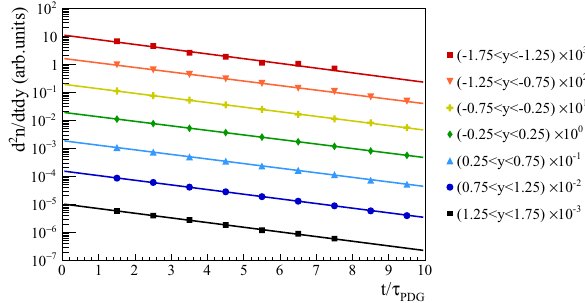
Fig. 7 Corrected lifetime distribution for K 0 inelastic p+p interaction at 158 GeV / c . The curves show the result of the exponential fit function used to obtain the mean lifetime. Statis- tical uncertainties are smaller than marker size and not visible on the plot